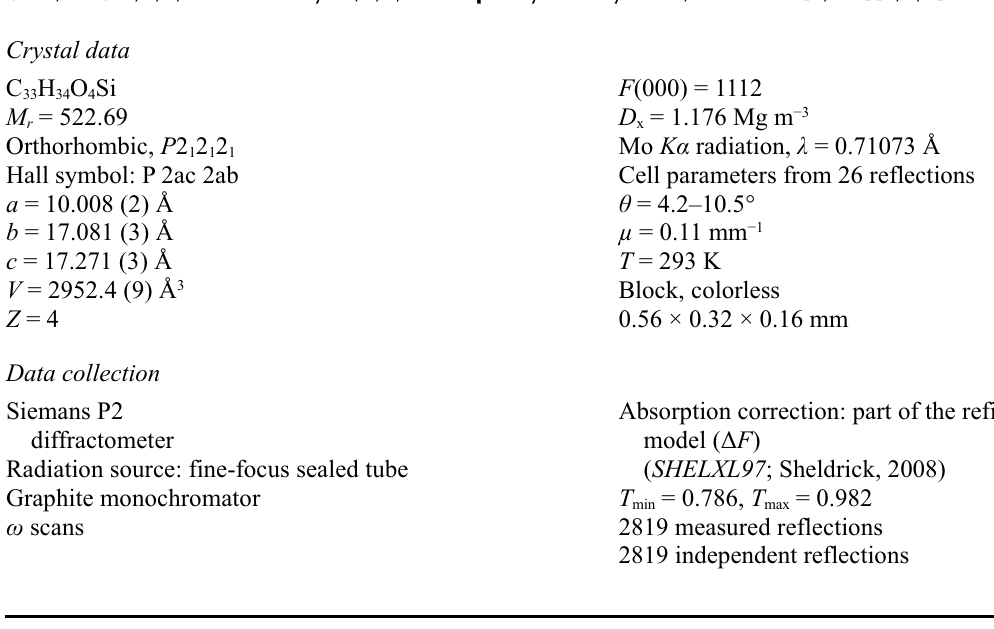
Packing diagram of the title compound, viewed down the a